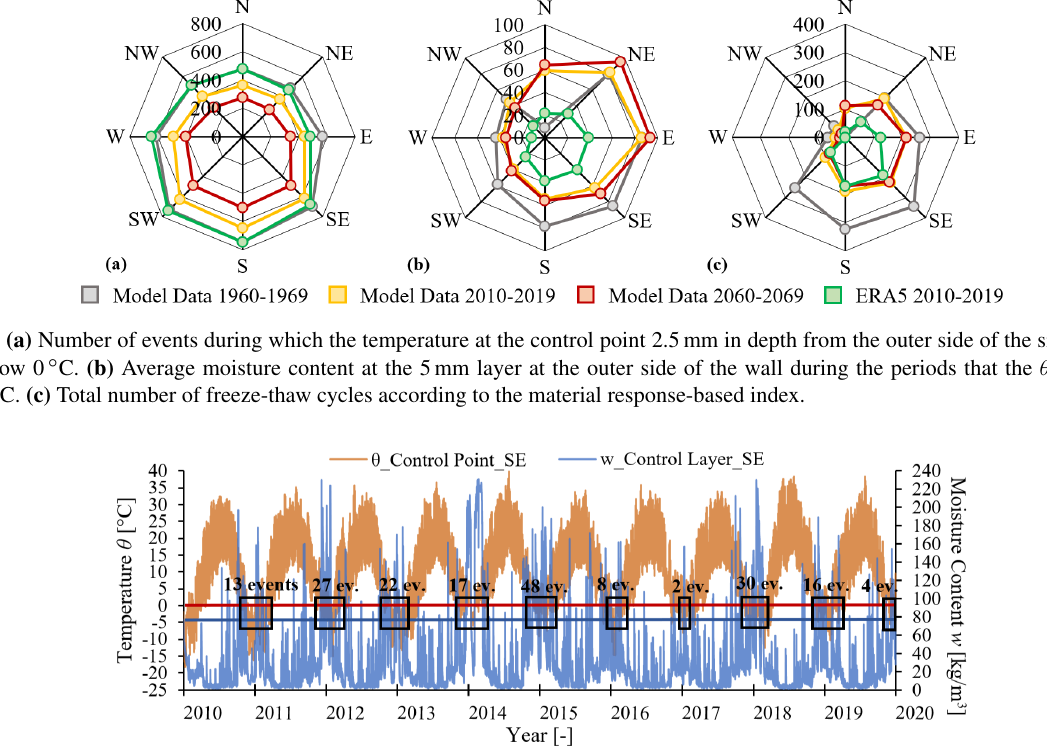
Figure 9. Hourly data of temperature at the control point 2.5mm in depth from the outer side of the simulated wall and moisture content at the 5mm layer at the outer side of the wall. The critical temperature, 0 ◦ C, is highlighted with a red line, and the critical moisture content, 77.5kgm − 3 is highlighted with a blue line. The freeze-thaw events are pointed in black boxes. Within the hygrothermal simulations, the indoor air temperature and relative humidity were considered equal to the outdoor